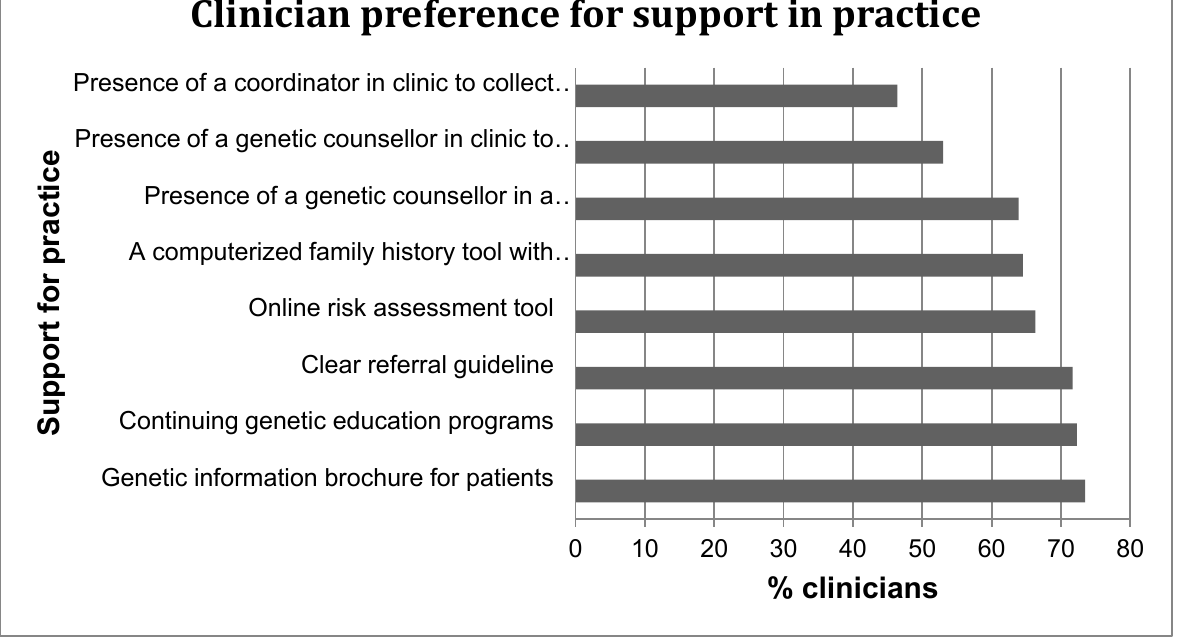
Figure 1. Desired support for the delivery of genetic services among health care